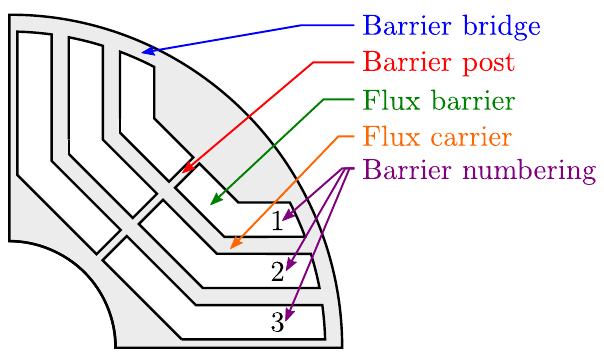
Figure 1. SyRM rotor nomenclature [3].